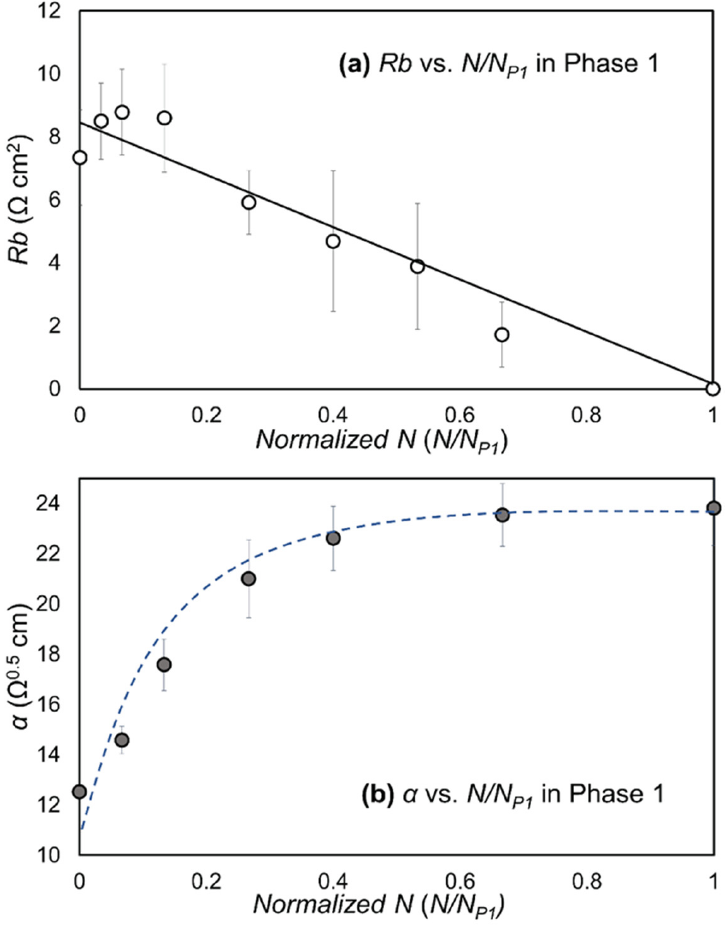
Figure 11. Plots of ( a ) Rb vs. N/N P 1 and ( b ) α vs. N/N P 1 in Phase 1. Error bars are standard deviations between nodes. Trendline for Rb is based on a linear regression.